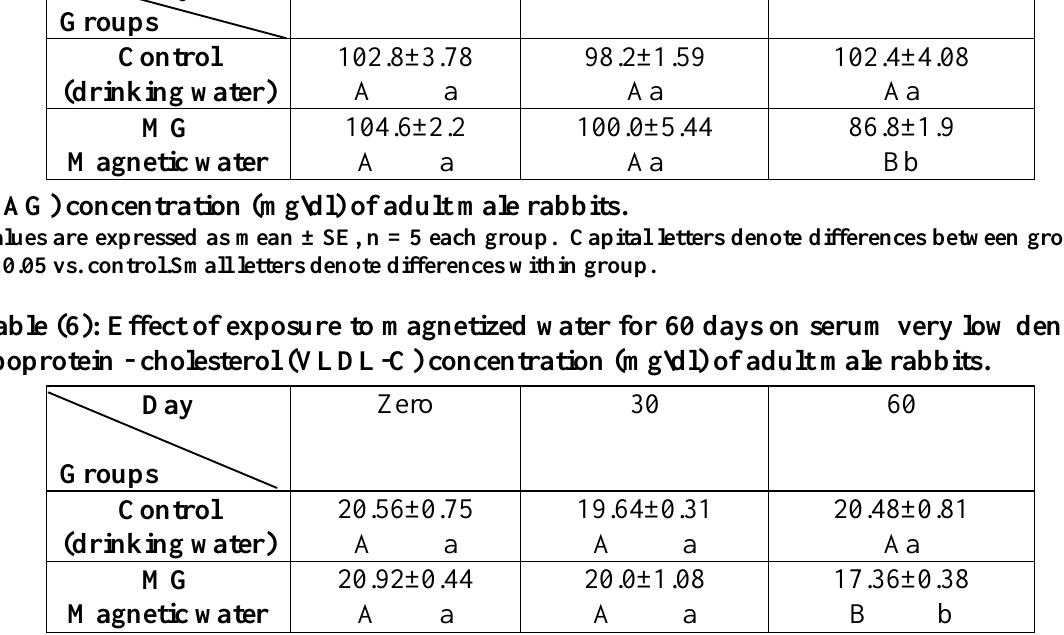
Values are expressed as mean ± SE, n = 5 each group. Capital letters denote differences between groups, P<0.05 vs. control.Small letters denote differences within group. Table (7): Effect of exposure to magnetized water for 60 days on serum high density lipoprotein - cholesterol (HDL-C) concentration (mg\dl) of adult male rabbits.